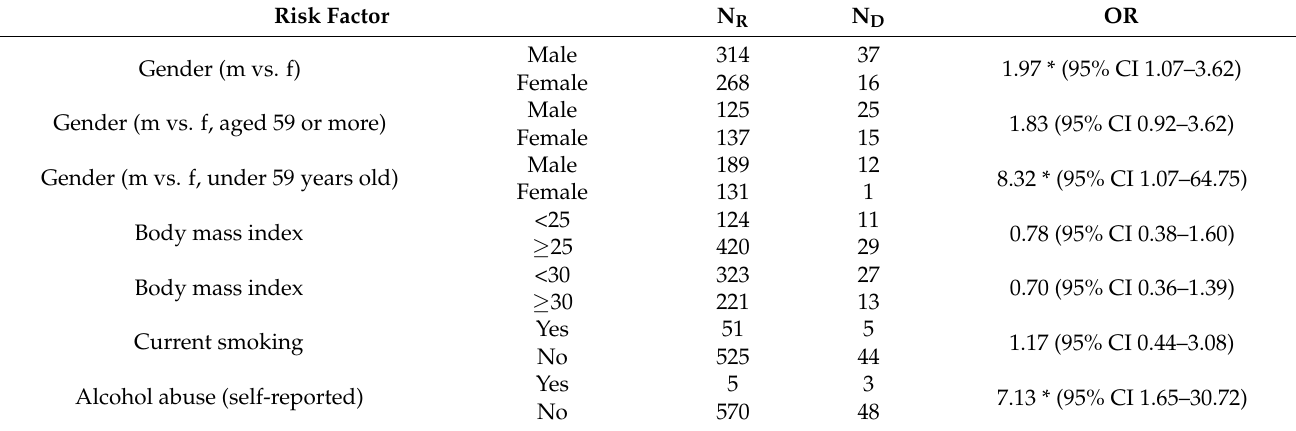
Current smoking Alcohol abuse